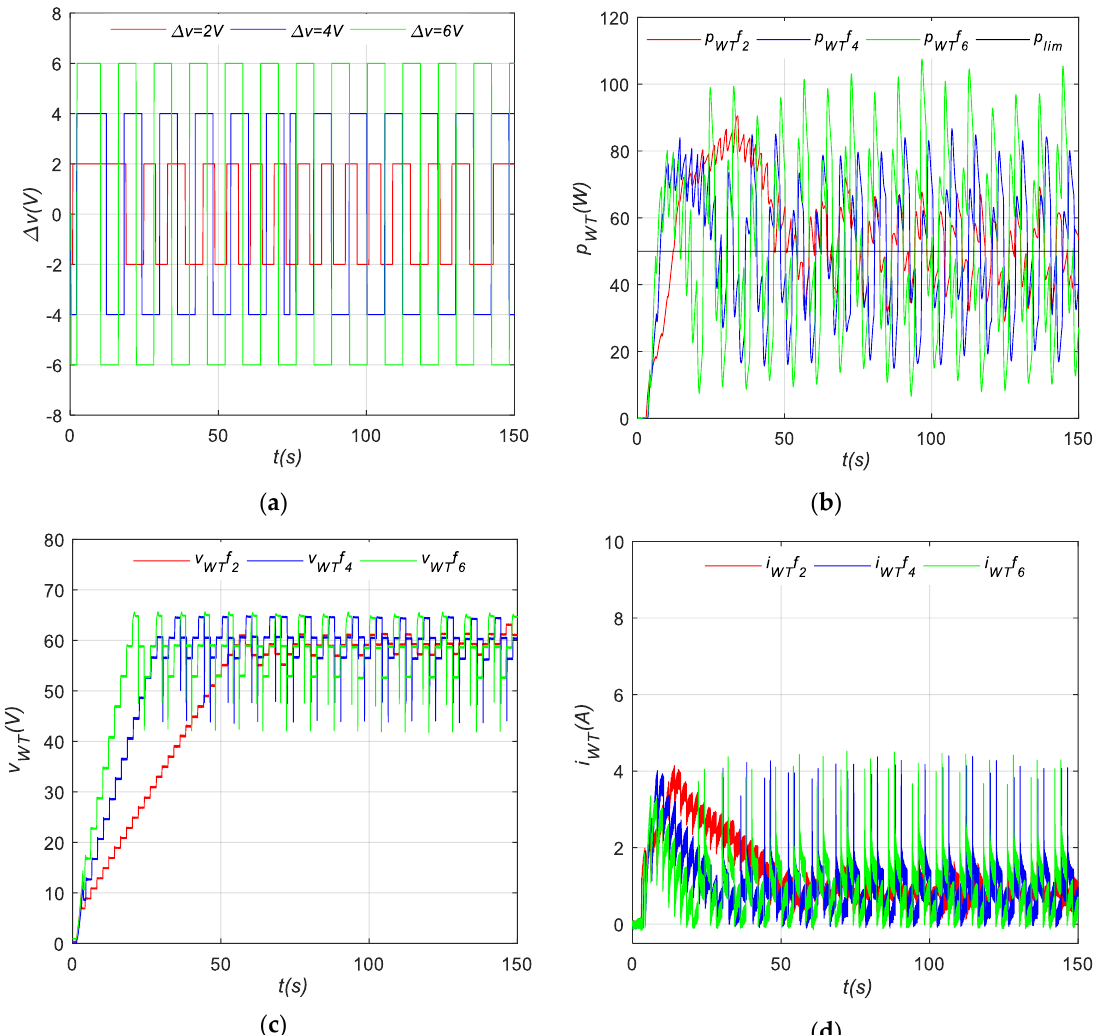
Figure 10. Fixed step-size P&O for LPP2: ( a ) evolution of ∆ v ; ( b ) evolution of p WT ; ( c ) evolution of v WT ; ( d ) evolution of i WT .